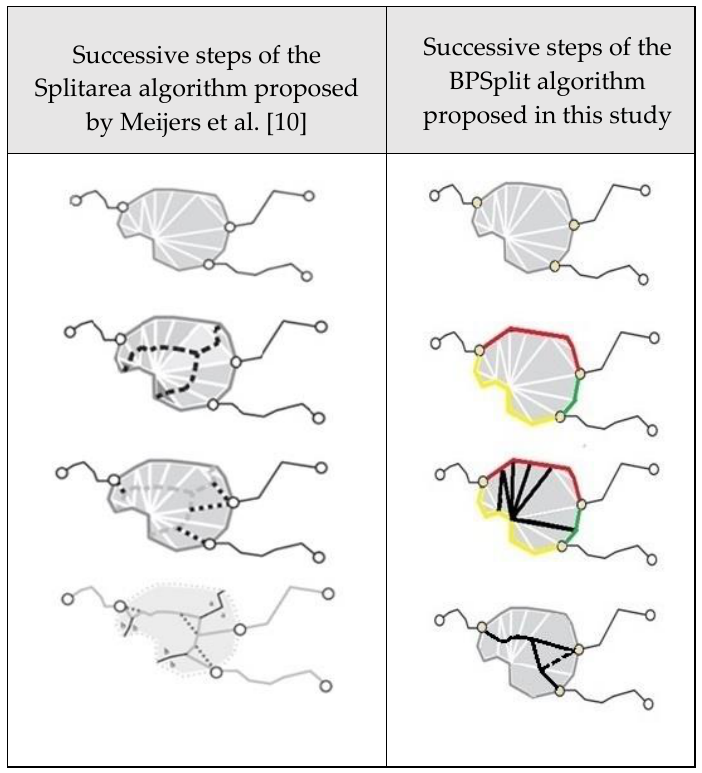
Figure 5. Successive steps of the algorithm generation process with the use of Splitarea [10] and BPSplit algorithms. The operations involving Table 1 data were